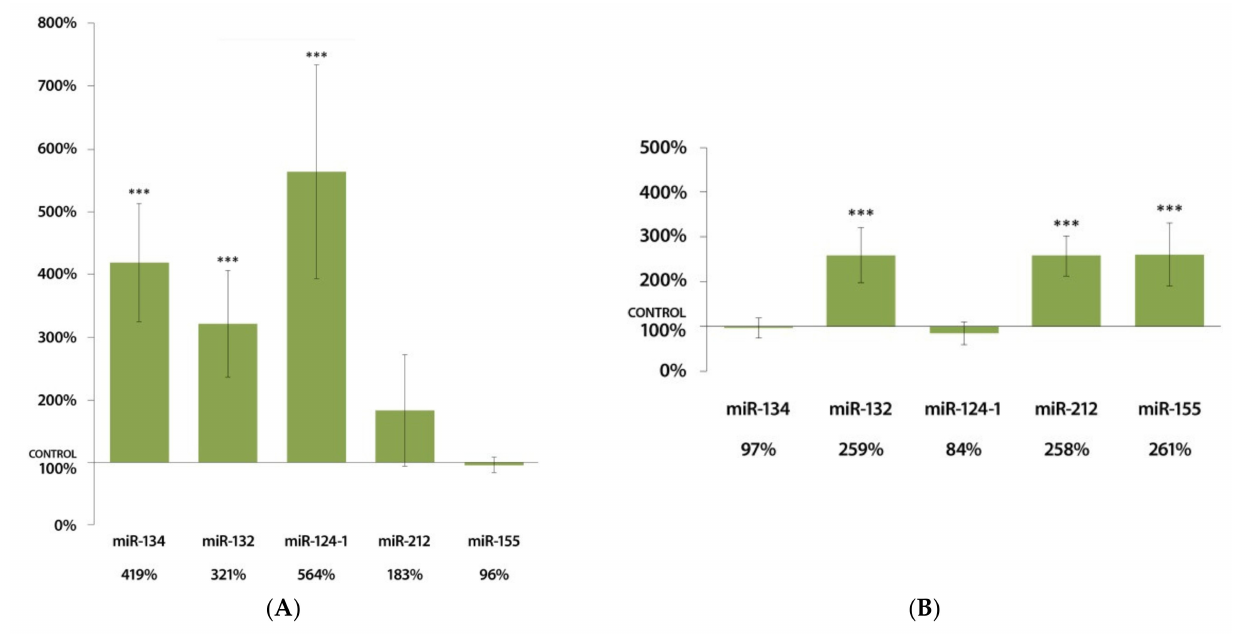
Figure 2. Expression results of miR-134, miR-132, miR-124-1, miR-212, and miR-155 in the spleen of ( A ) female and ( B ) male CBA/Ca mice 24 h after DMBA treatment, compared to non-treated mice (100%) (*** p <